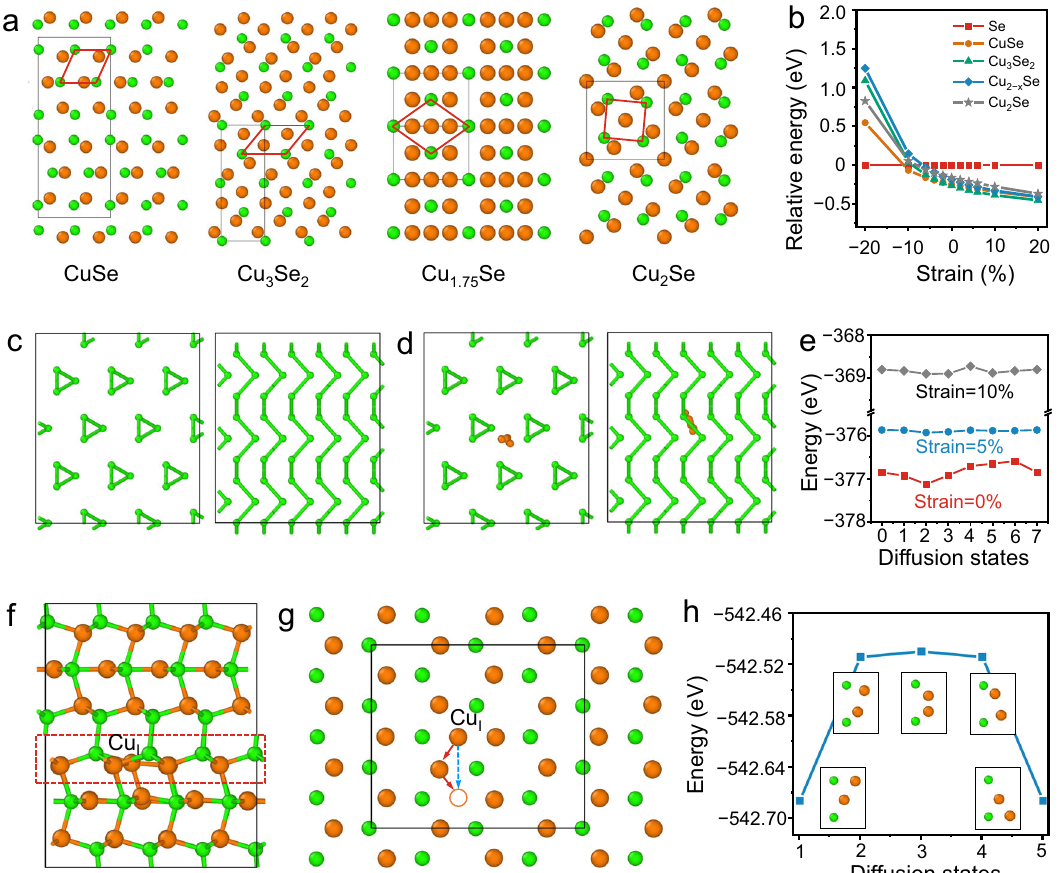
Fig. 6 First-principle calculations of the four-electron selenium cathode chemistry. a Atomic structures of CuSe, Cu 3 Se 2 , Cu 1.75 Se, and Cu 2 Se and their unit cells are marked with black color, and Se parallelepiped skeleton are marked with red color; to simplify calculation, Cu 1.75 Se is used as a representative form of Cu 2 − x Se. b The relative total energy (per atom) of Se, CuSe, Cu 3 Se 2 , Cu 1.75 Se, and Cu 2 Se with respect to strain; The variation of particle number density over the entire process is about 69% corresponding to 19% deformation in length, therefore strain ranges from − 20% to 20% in our calculation; The top and side view of crystalline Se ( d ) with or ( c ) without copper-ion embedded; Note that only one copper ion is embedded here, multiple ions appear in ( d ) are used to describe the trajectory of copper ions diffusion, and the corresponding energy variations along this trajectory under different volumetric deformation (0%, 5% and 10% equal-axis strain) are shown in ( e ). f The side and g top view of CuSe with one copper-ion embedded; In g , only one slice of f (marked with the red dash line) is shown to facilitate viewing the diffusion path of the interstitial copper ion (marked by Cu I in f and g ). h The energy curve of copper-ion diffusion in CuSe, and the local atomic structures at different transition states are given in